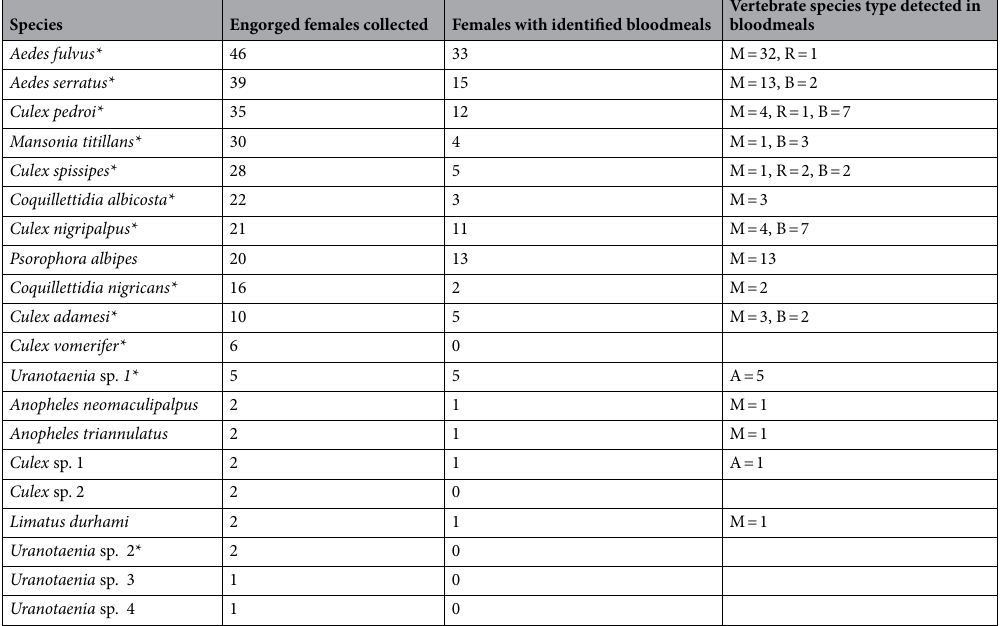
Table 1. Diversity and abundance of blood-engorged female mosquitoes collected from March 2017 to April 2018 using four sampling methods in forest fragments in San Juan Carare, Colombia. The abundance of each species is calculated relative to the total number of engorged females collected (N = 292). The number of bloodmeals identified includes the result of Cyt-b and COI amplifications (N = 112). *denotes species confirmed using DNA barcodes. Mammals (M), Reptiles (R), Birds (B) and Amphibians